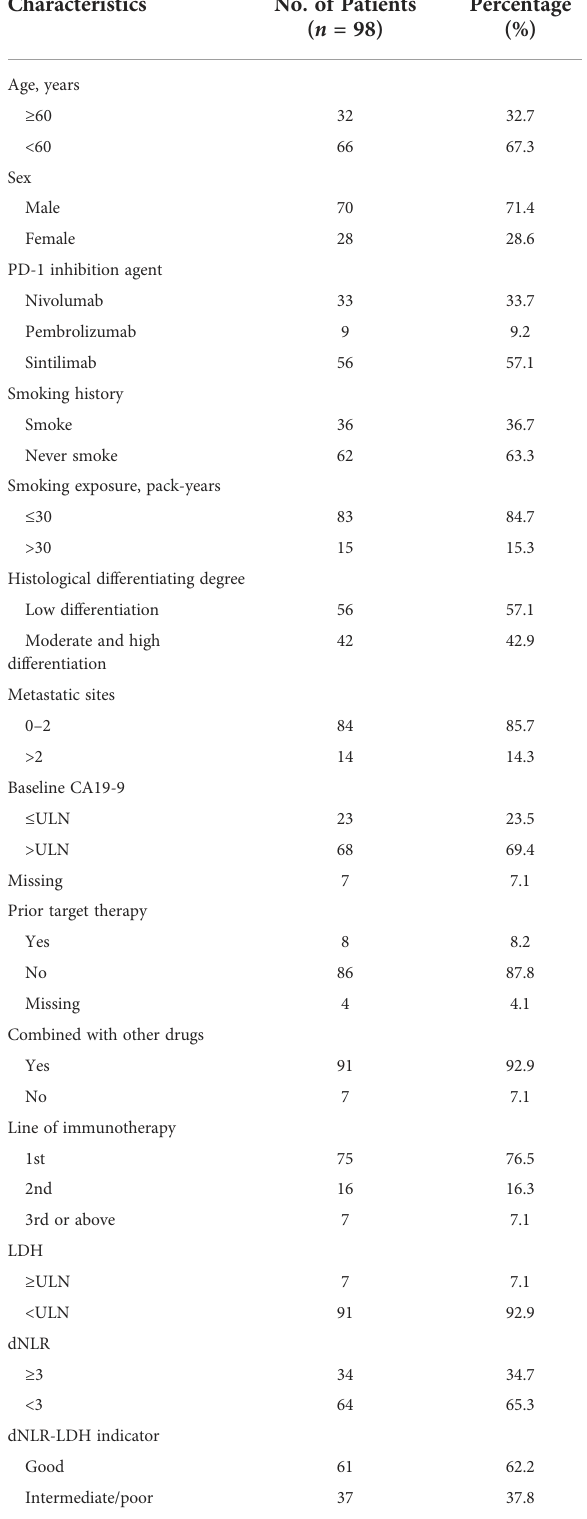
TABLE 1 Characteristics of patients with advanced